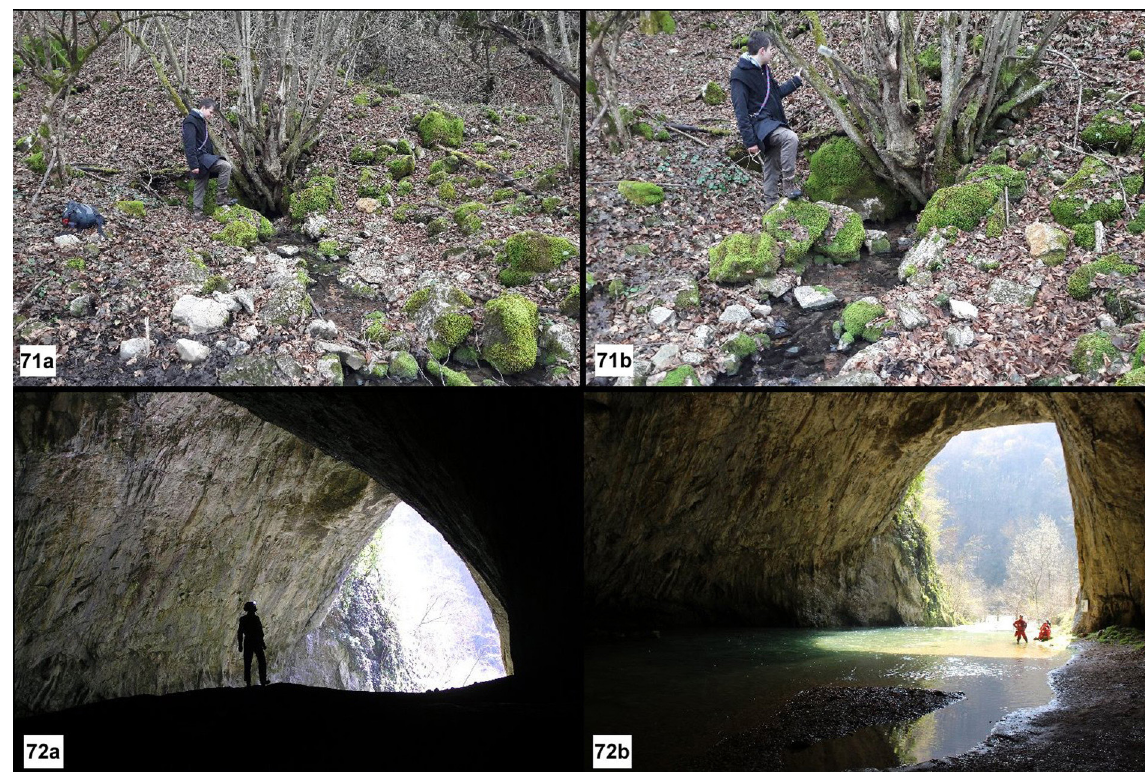
Fig. 5. Type locality of H. lozekiana sp. nov. (71) and Dabarska Pećina, a locality of H. steffeki sp. nov. (72) (see Table